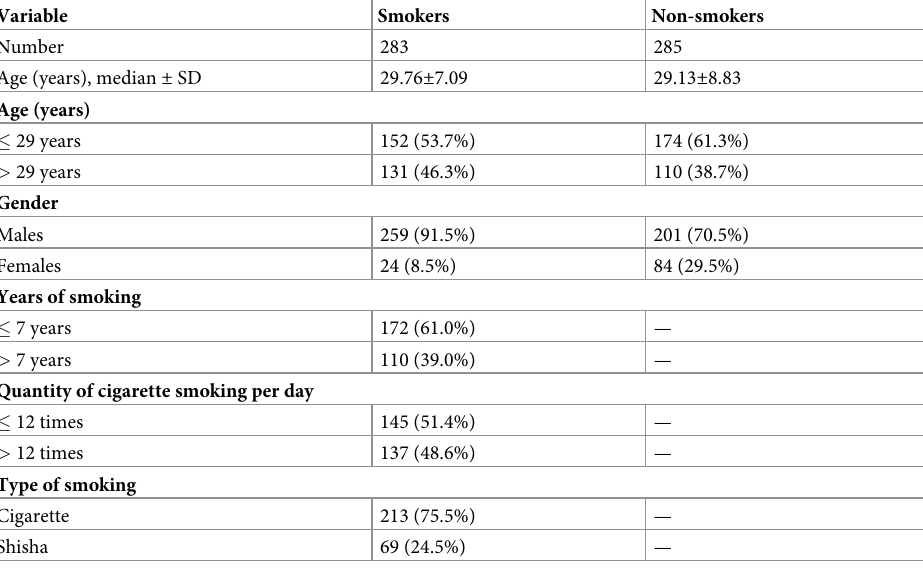
Table 1. Clinical and demographic data of the study